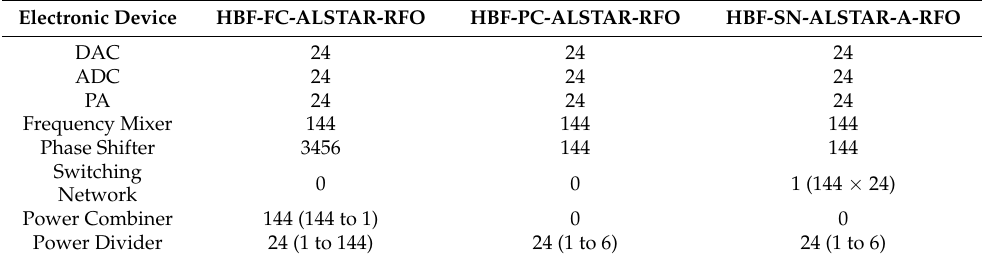
Table 2. The number of different electronic devices for three simplified structures. (NRF = 24).